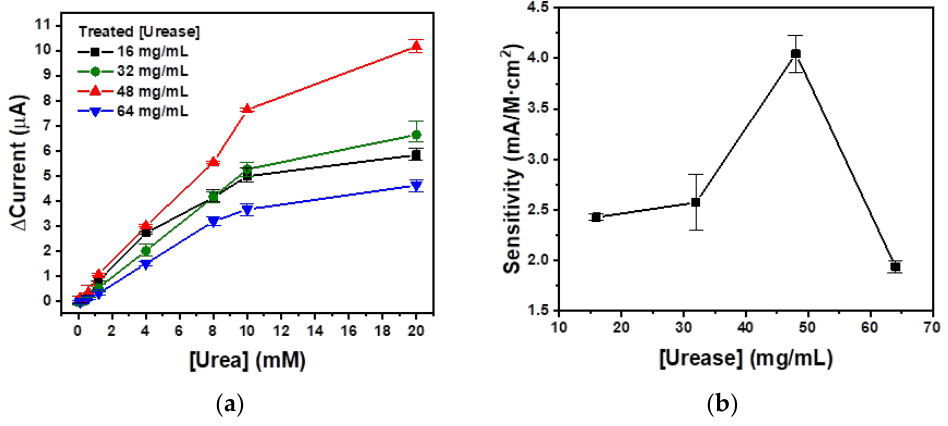
Figure 4. ( a ) Chronoamperometric urea sensing and ( b ) sensitivities with various concentrations of urease-treated SF membranes for the optimization of urease concentration.